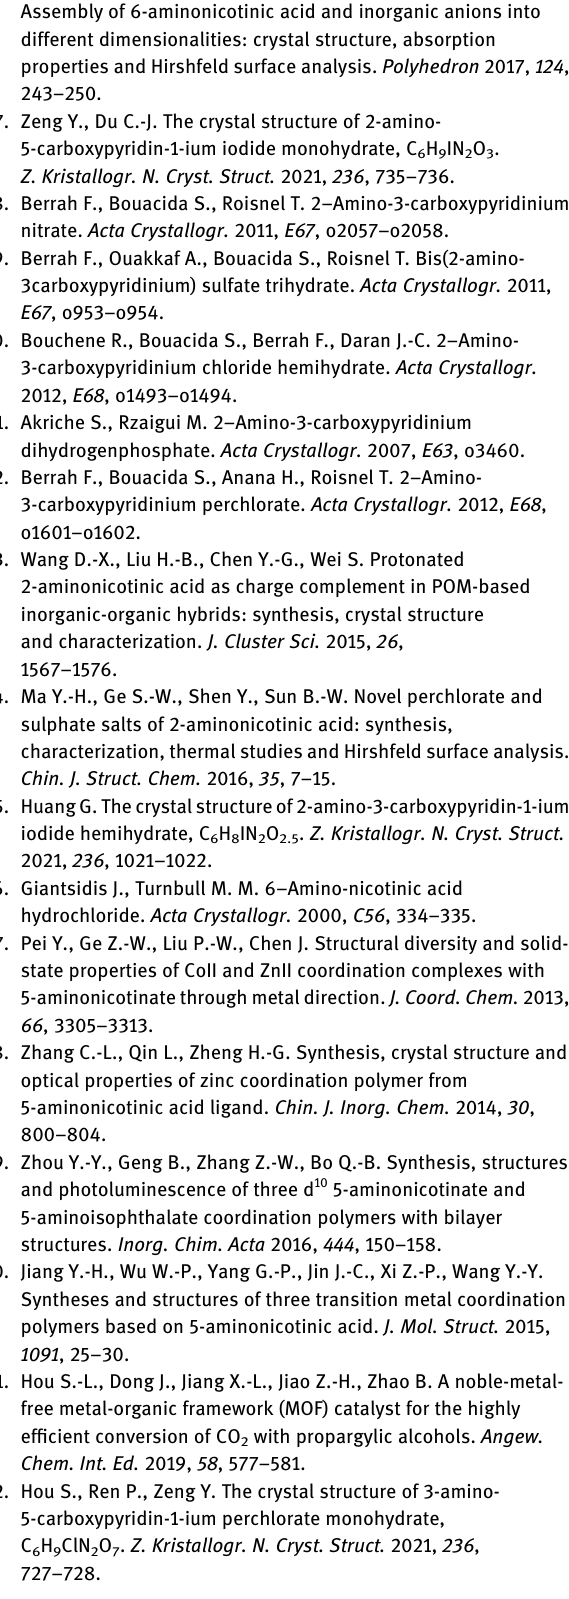
Table  : Fractional atomic coordinates and isotropic or equivalent isotropic displacement parameters (Å 